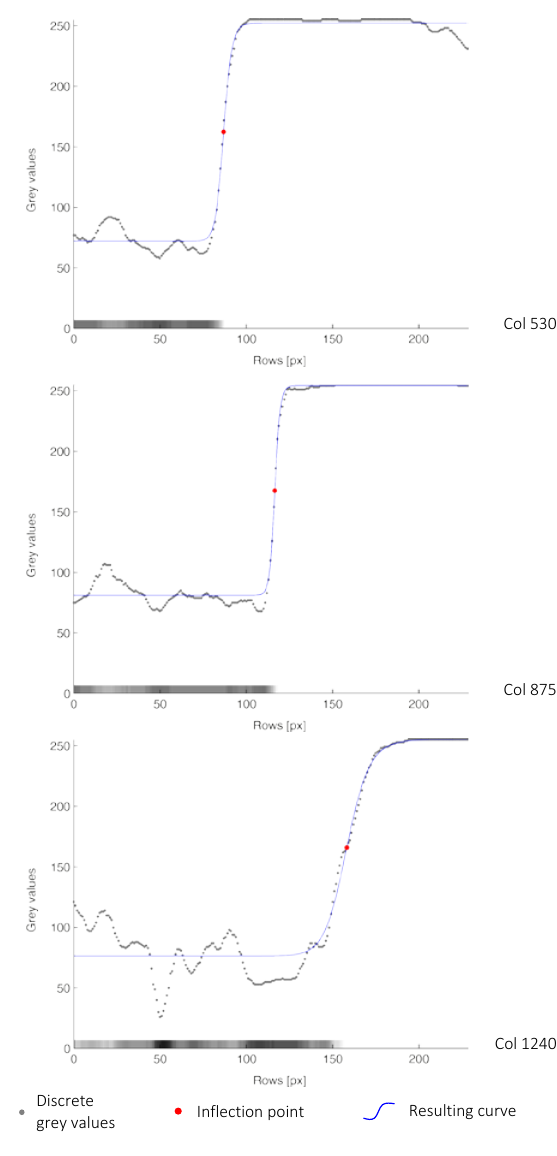
Figure 7: Exemplary column-by-column four-parameter logistic regression curve fit for col 530, 875 and 1240 (referring to dashed lines of Figure 1)